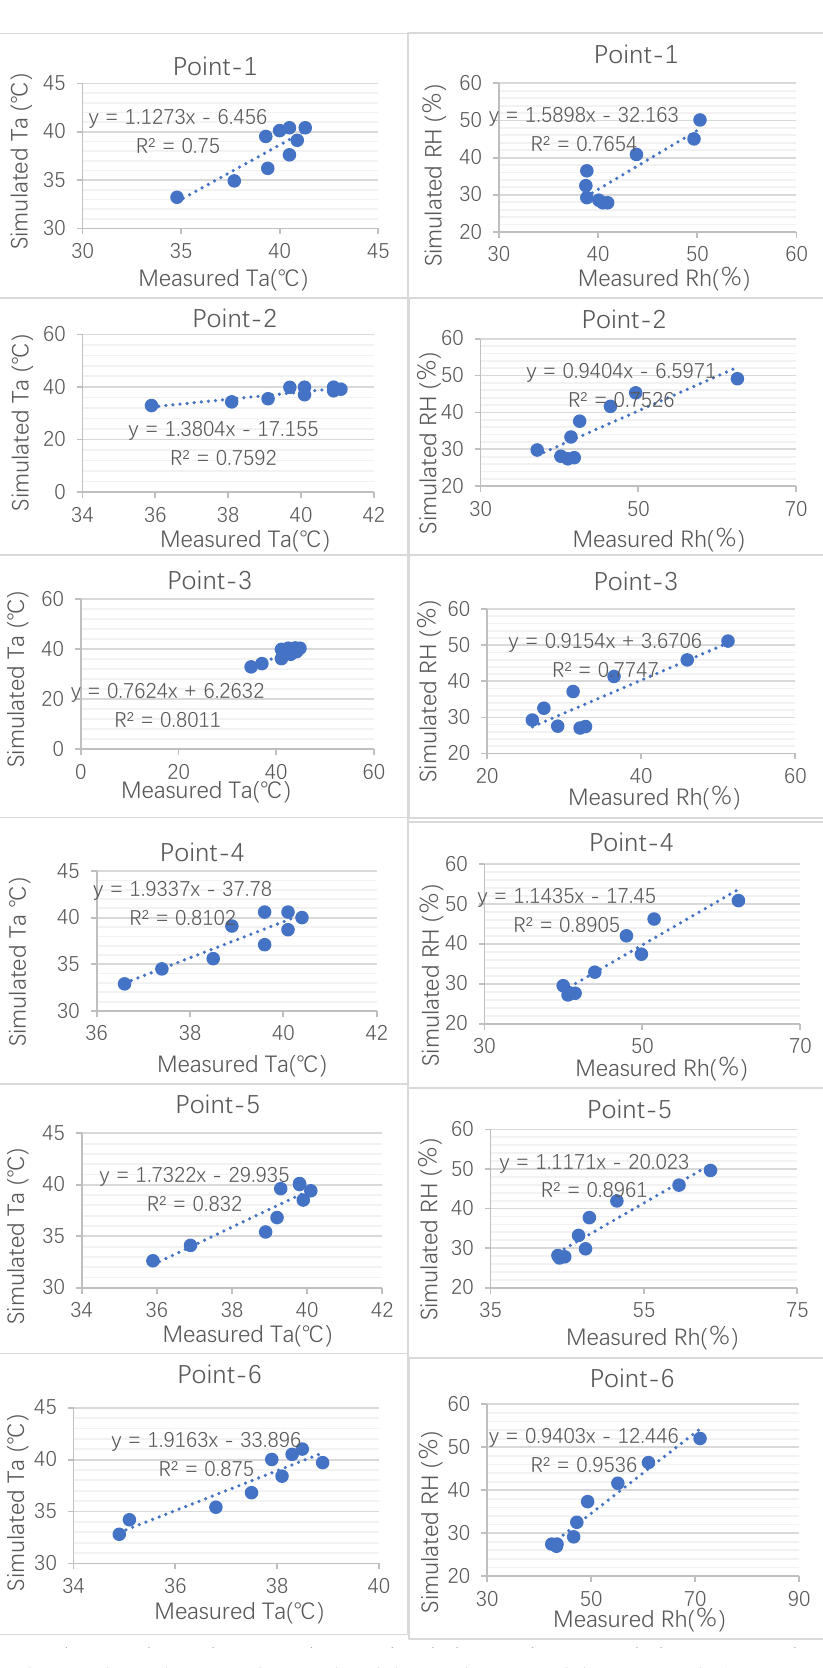
Figure 11. The correlation between the simulated data and measured data on 31 July (Ta air temperature, RH relative humidity) [18].